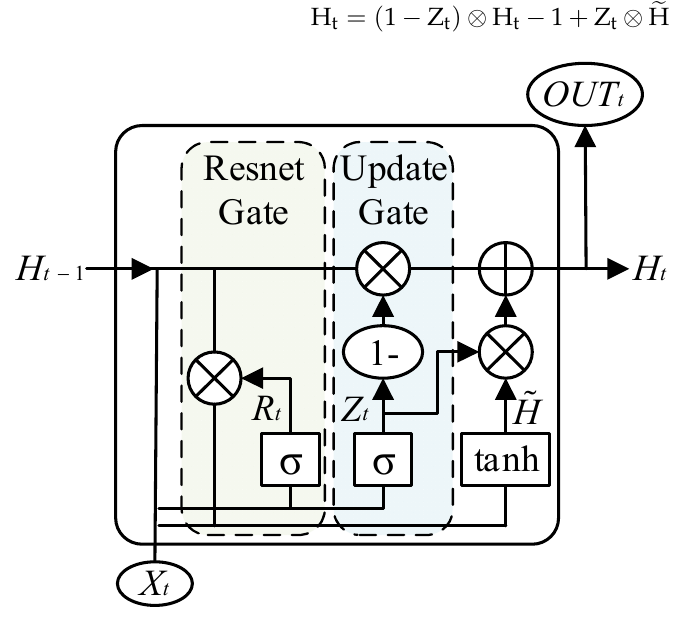
Figure 2. The structure of GRU.